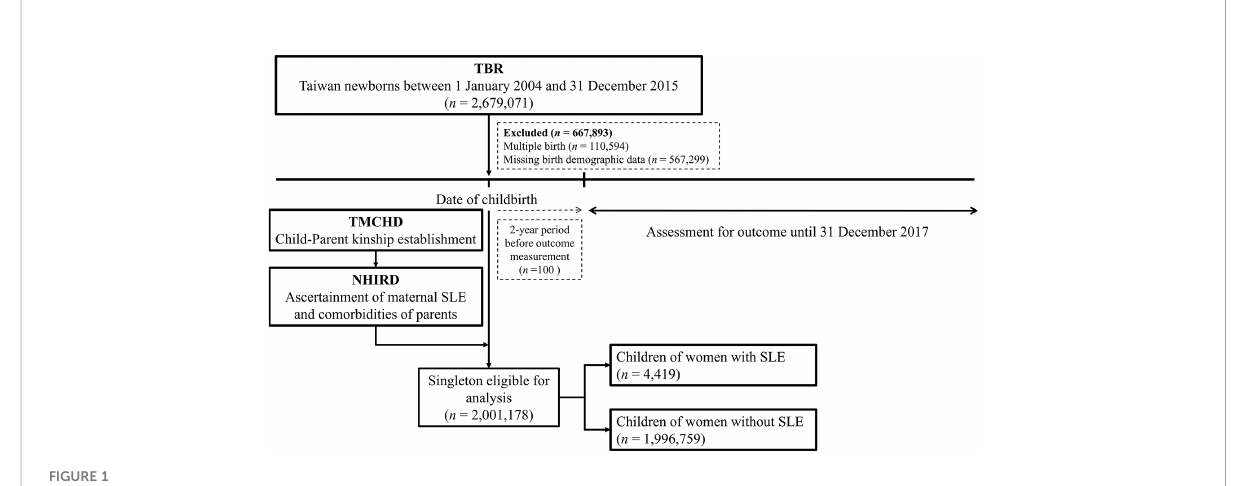
FIGURE 1 Flow chart of the study